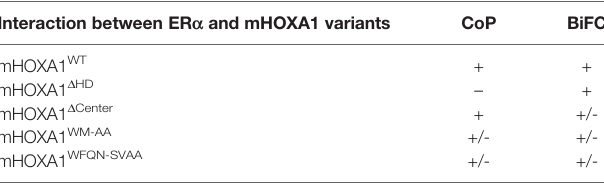
TABLE 4 | Comparative table for CoP and BiFC interaction